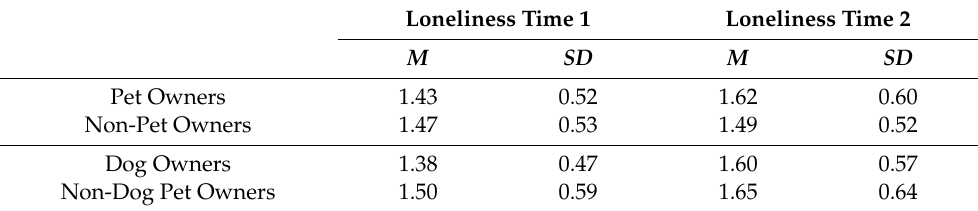
Table 2. Loneliness at Time 1 (pre-COVID) and Time 2 (during COVID), by pet ownership status.